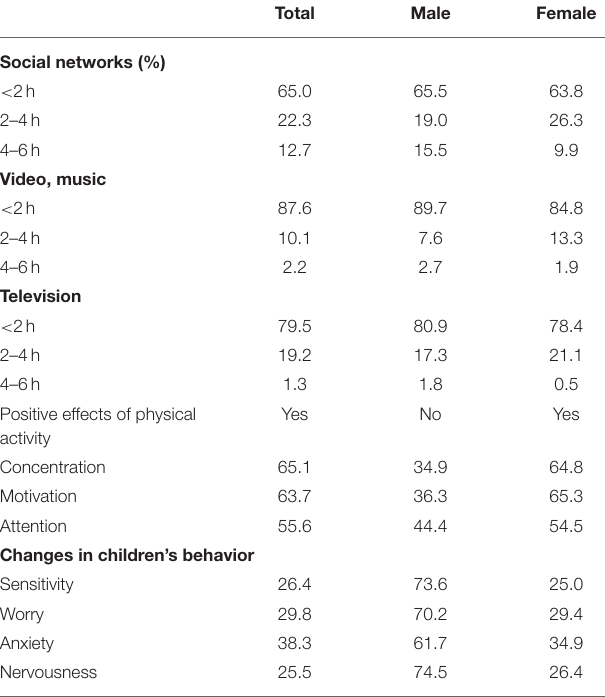
TABLE 1 | Descriptive statistics of children’s school achievement and physical activity before COVID-19 emergency measures (EM) and children’s daily routine during COVID19